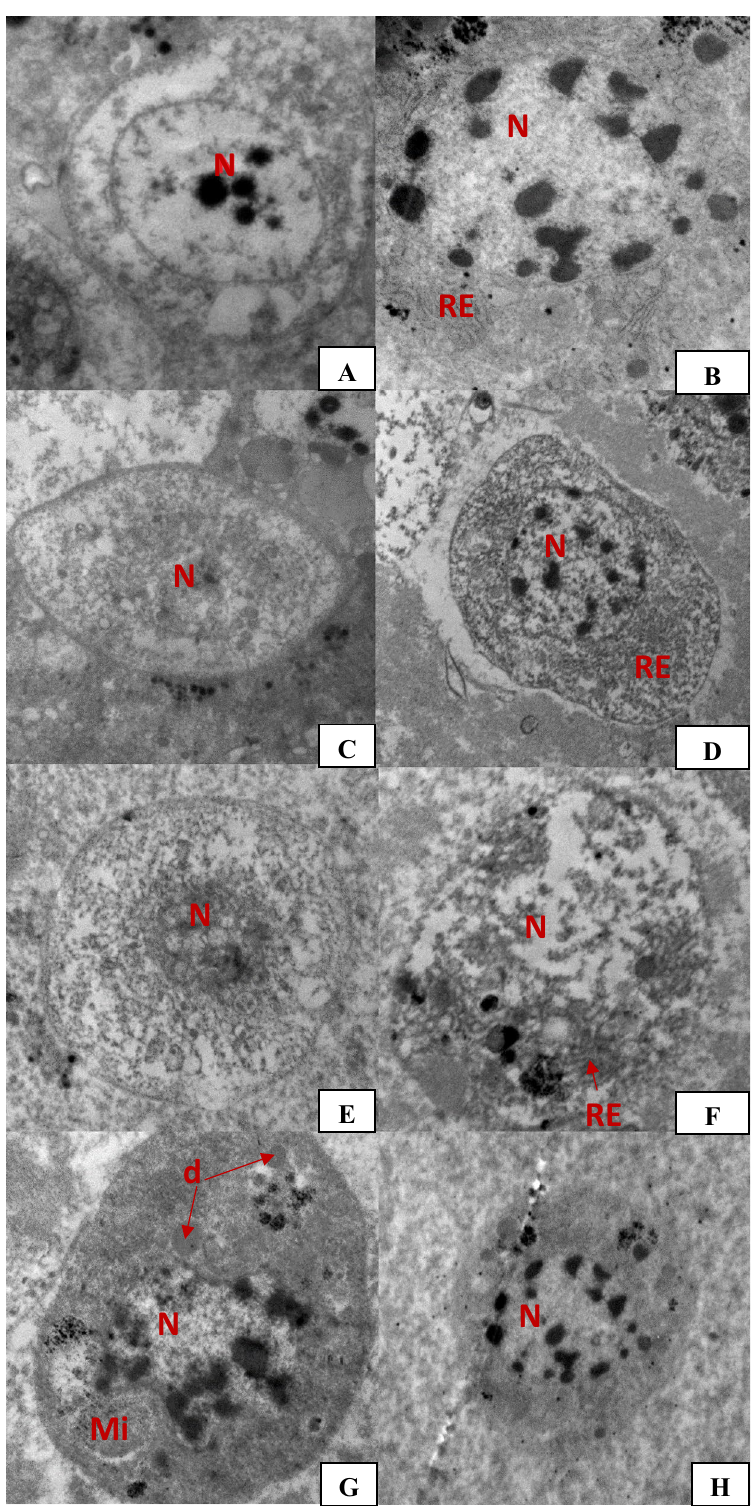
Fig. 3 Electromicrographs of the ultrastructure of hemocytes of fully developed larval instar of Corcyra cephalonica in normal physiological state A , B Prohemocyte; C , D : Plasmatocytes; E , F : Granulocytes; G : Spherulocytes; H : Oenocytoids with Nucleus (N); mitochondria (MI); Rough endoplasmic reticulum (RER); Electron Dense Granules (d). Scale bar represents 500 nm ( A , C , D , E , F , G , H ) and 100 nm ( B